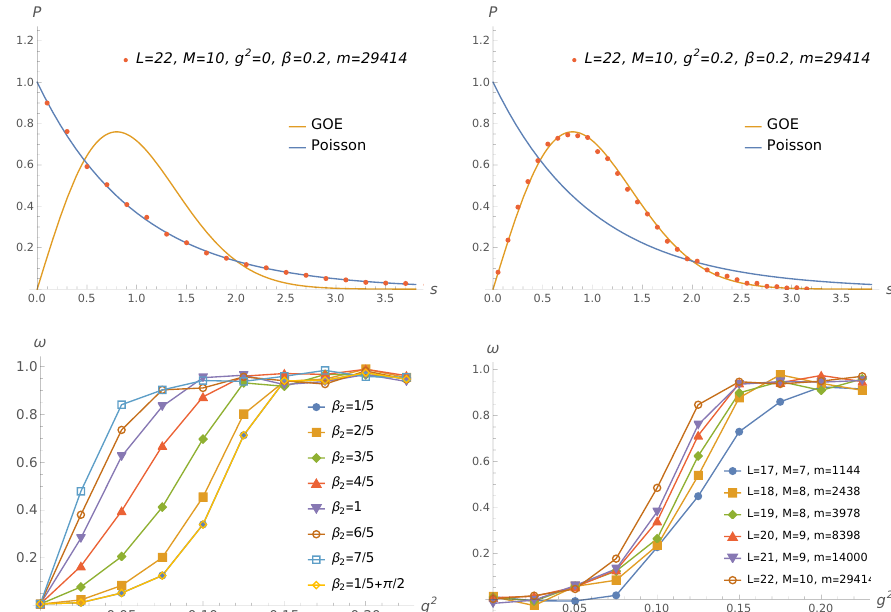
Figure 2 . Top row: distribution of level spacings of the deformed two-loop spin chain for L = 22 , M = 10 zero-momentum operators with β = 1 / 5 and g 2 = 0 and 0 . 2 . Bottom left: Brody-distribution parameter ω as a function of g 2 for zero-momentum states with L = 20 , M = 9 for β = 1 / 5 and β 2 ∈ [ 1 , 1 + π ] . Bottom right: Brody-distribution parameter ω as a function of g 2 for spin chains of 5 5 2 varying length, L ∈ [16 , 22] , with β = β 2 = 1 / 5